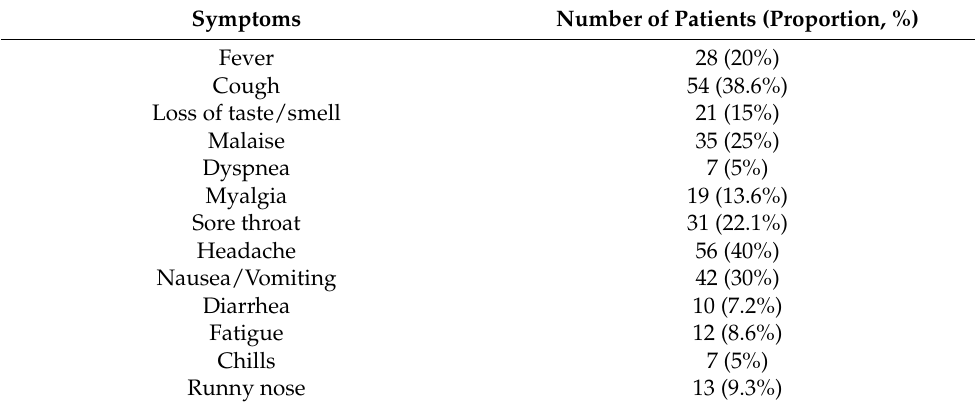
Table 1. COVID-19-positive pregnant patients’ symptoms in the preoperative period. Symptoms Number of patients (proportion, %).